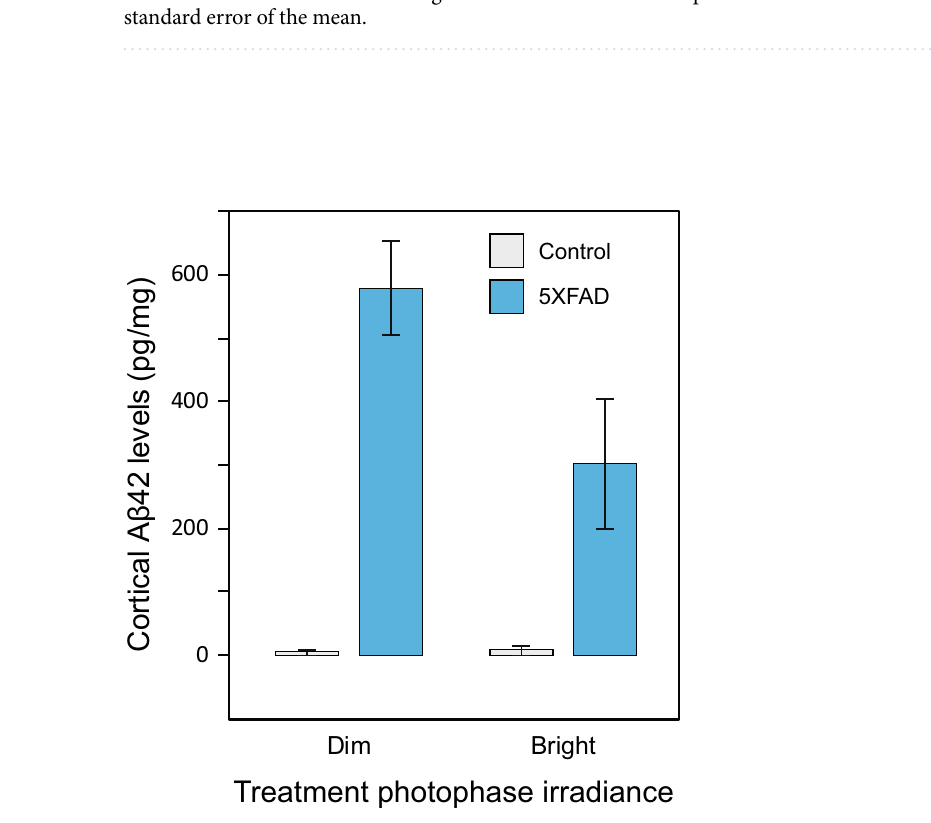
Figure 3. Significant interaction between the main effects of genotype (control vs. 5XFAD) and treatment photophase irradiance (dim vs bright) on cortical Aβ42 levels (pg/mg) (assessment age = 343 days). In the 5XFAD mice, levels of cortical Aβ42 were significantly higher in those exposed to dim light than in those exposed to the bright light, while there was no significant difference in cortical Aβ42 levels in the control group. Reported mean values for each condition have been averaged across the rest of the independent variables. The error bars represent standard error of the